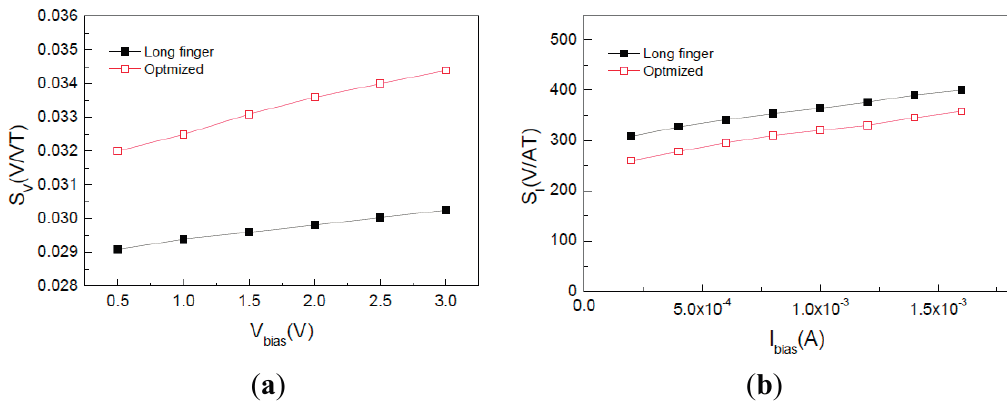
Figure 3. Magnetic sensitivity comparison of long-finger and optimized Hall plates. ( a ) S V ; ( b ) S I